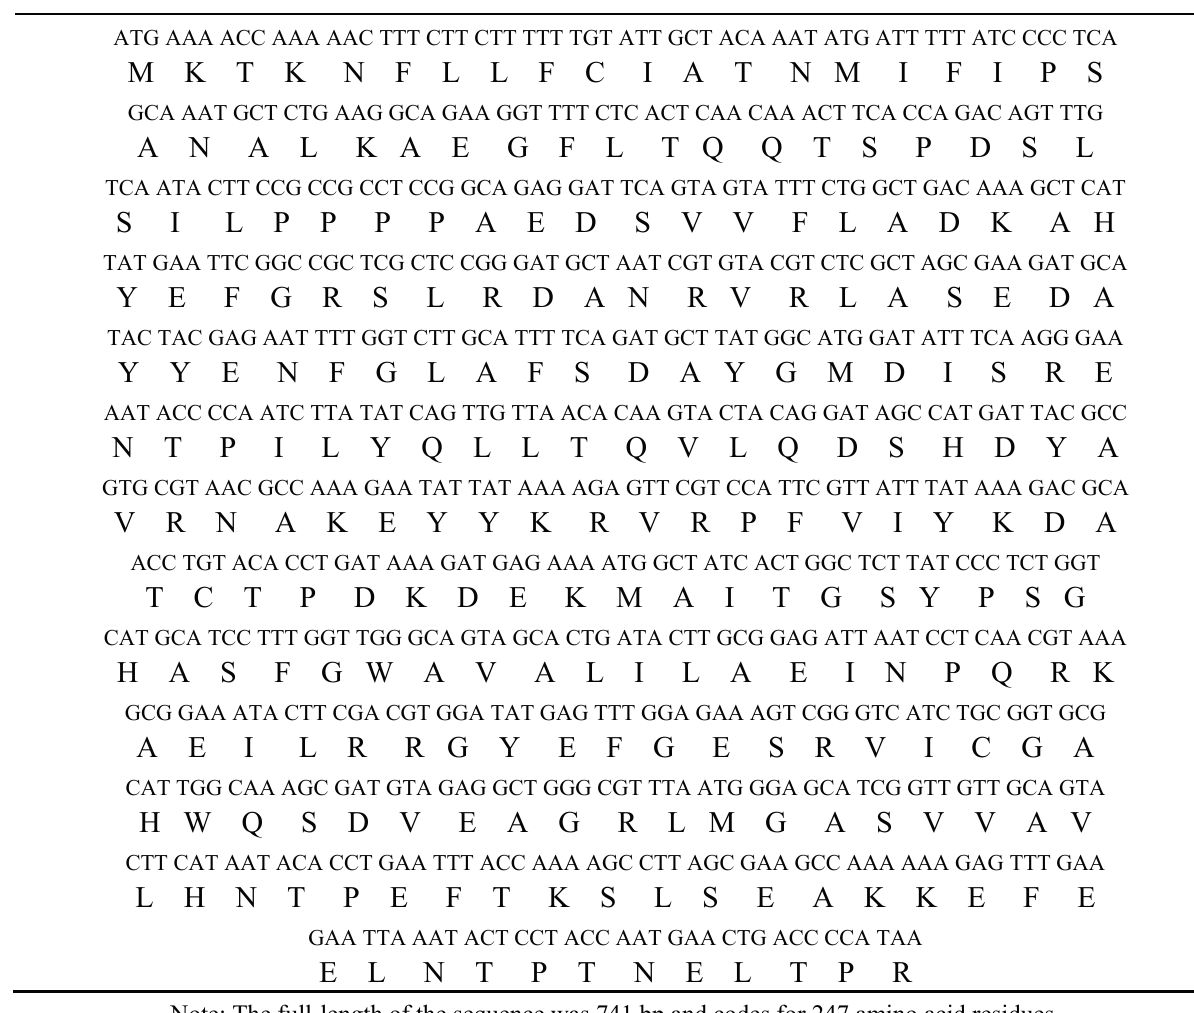
Table 2. Sequence analysis of Apyrase gene and its encoding amino